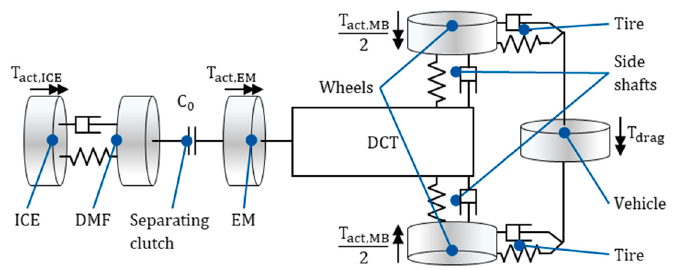
Figure 6. Structure of the torsional vibration model used for the hybrid drivetrain. For the conventional drivetrain the torque T act,EM is omitted and the inertia at the transmission input is added to the inertia of the clutch